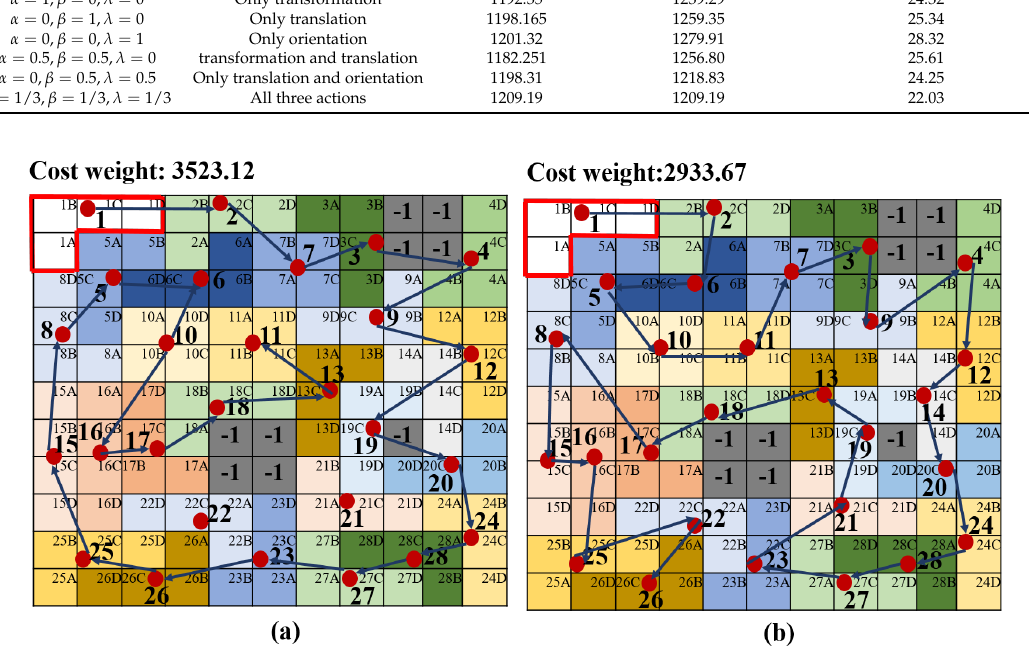
Figure 15. Optimal trajectories with different actions. ( a ) path considering translation, ( b ) path considering all 3 actions.